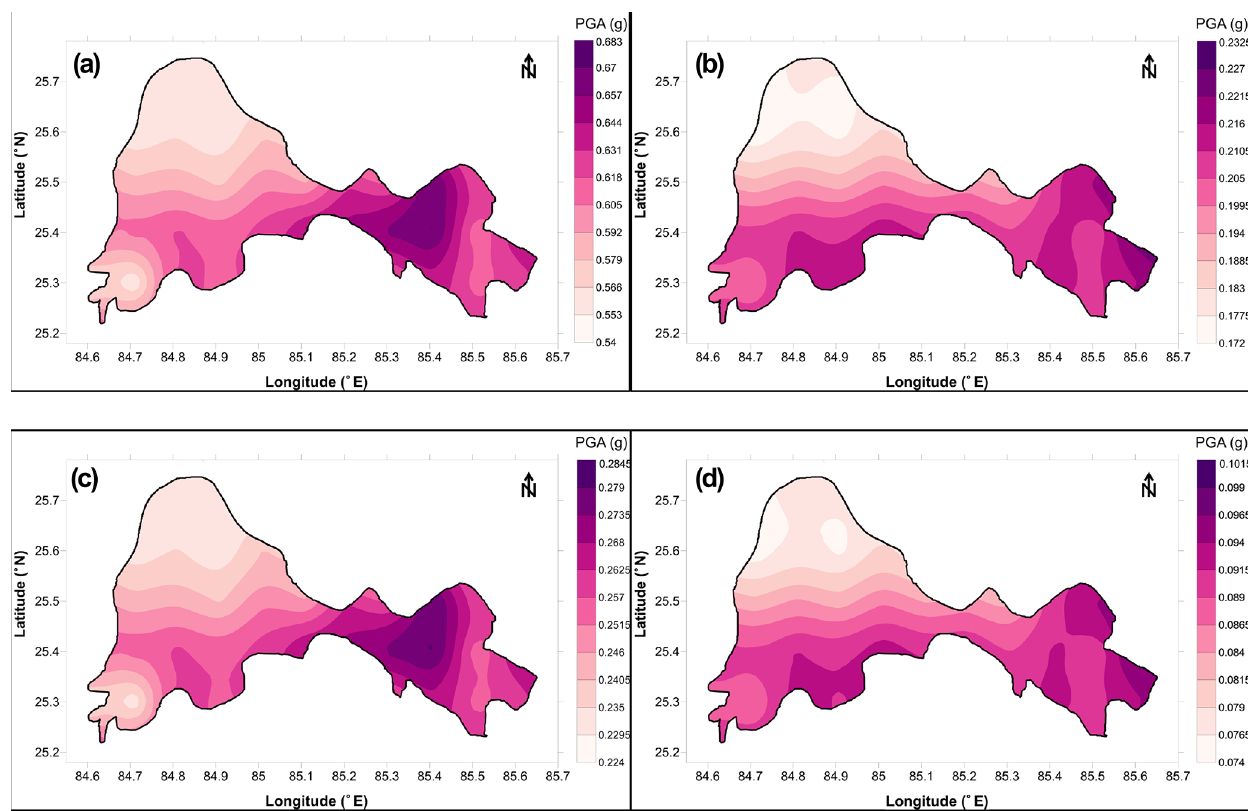
Figure 12. Final seismic hazard map of Patna SSA for (a) 2% and (b) 10% probability of exceedance in 50 years at 0.2s and (c) 2% and (d) 10% probability of exceedance in 50 years at 1s using the logic tree